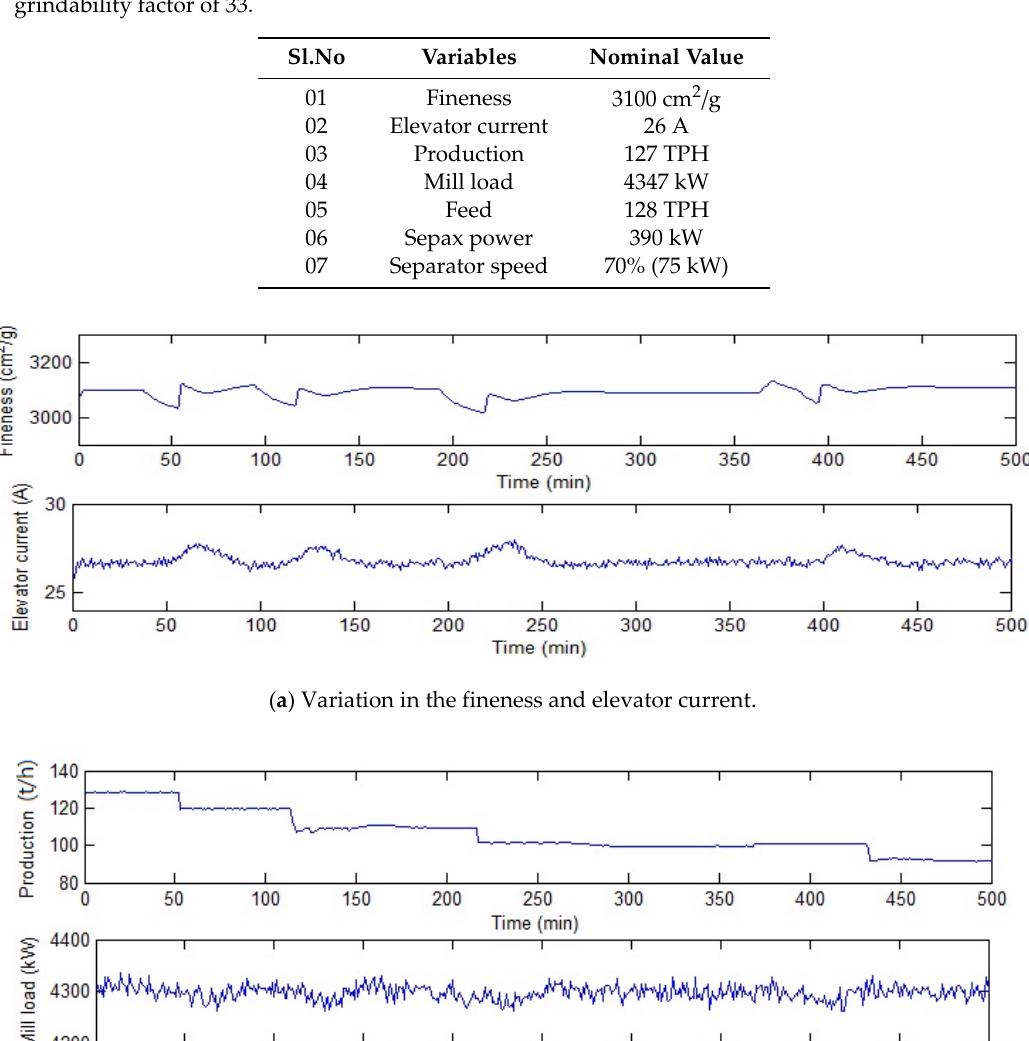
Table 2. Nominal values of the input and output variables in the real-time simulator for the clinker grindability factor of 33.